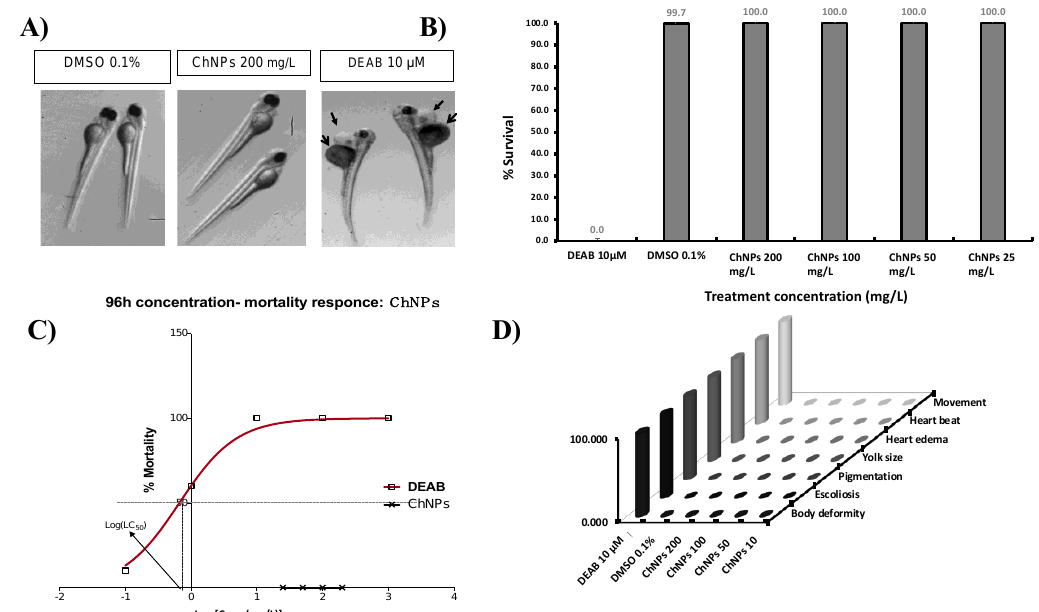
Figure 3. ( A ) Acute toxicity representative pictures obtained with a stereomicroscope at magnification X = 0.63. Note the deformed embryos in dimethylaminobenzaldehyde (DEAB): short size, scoliosis heart edema (closed arrow), and yolk edema (open arrow). ( B ) Cumulative survival/mortality. ( C ) Mortality response curve of different concentrations of DEAB and ChNPs. ( D ) Teratogenic phenotypes analysis. DEAB: Dimethylaminobenzaldehyde, positive control for toxicity and teratogenicity.